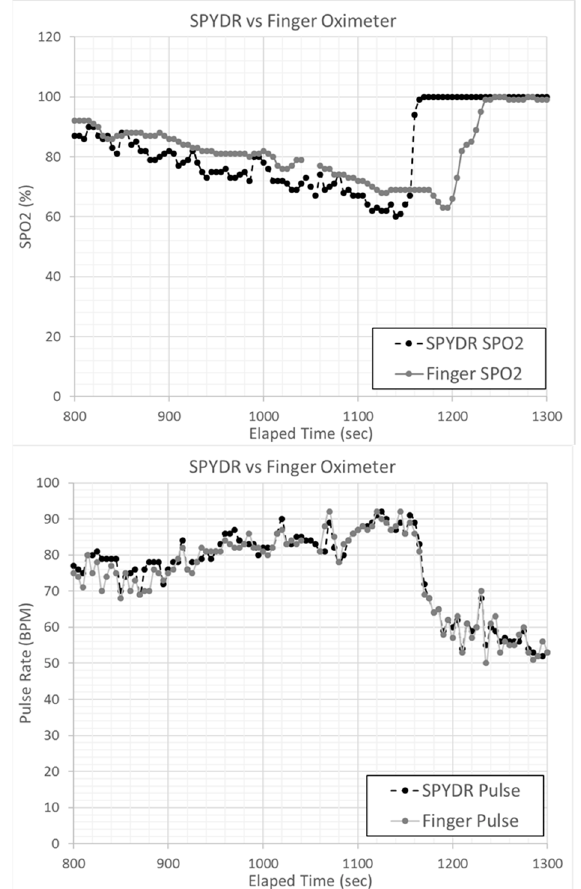
Figure 7. Exemplary overlay plot of SpO2 levels for SPYDR and a finger-based pulse oximeter. In ( a ) after initiating 100% oxygen at the lowest SPO2, SPYDR detected normal SpO2 levels 50 seconds faster than the finger-based sensor. ( b ) pulse rate comparison between SPYDR and finger for the same time period as SPO2 readings, validating the time synchronicity of the devices.